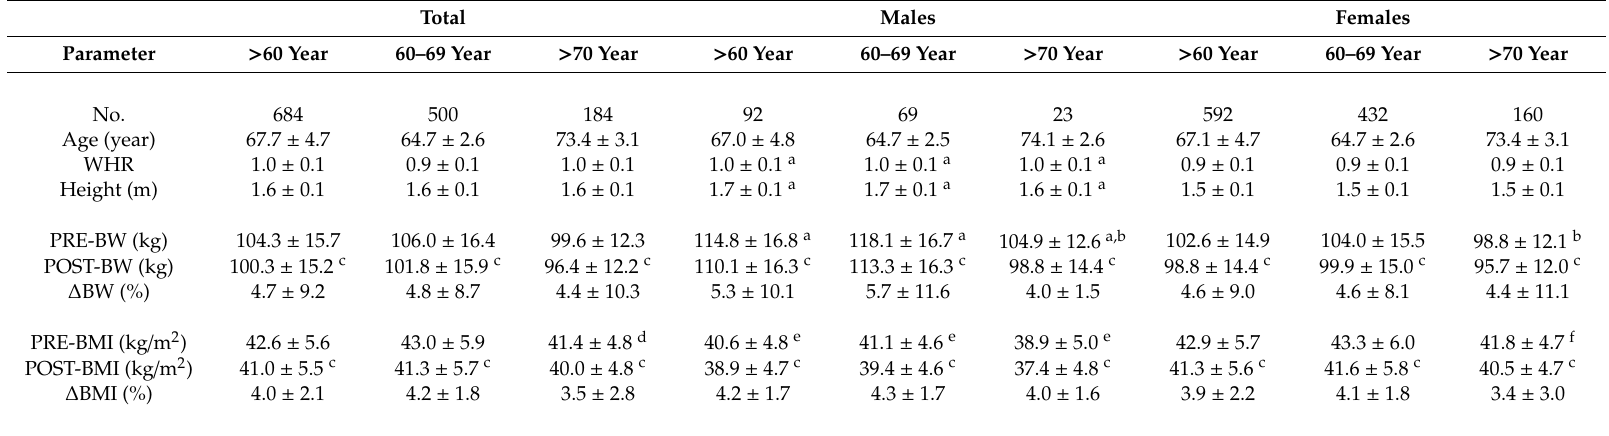
Table 1. Demographic and anthropometric characteristics of the study population (before and after